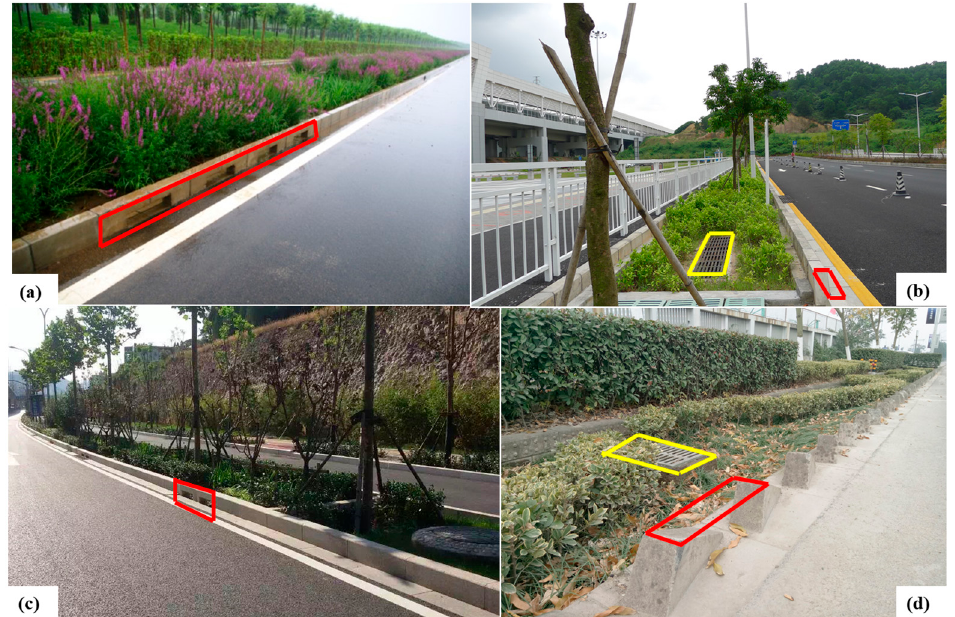
Figure 2. Continuous road-bioretention strip in ( a ) Beijing (curb inlet length L ci = 0.5 m) taken by Yongwei Gong, ( b ) Shenzhen ( L ci = 0.4 m) taken by Yongwei Gong, ( c ) Jinan ( L ci = 0.4 m) taken by Xiaoning Li, and ( d ) Ningbo ( L ci = 0.3 m) taken by Jianlong Wang. Red boxes show curb inlets and yellow boxes show overflow grate inlets in the bioretention cells.